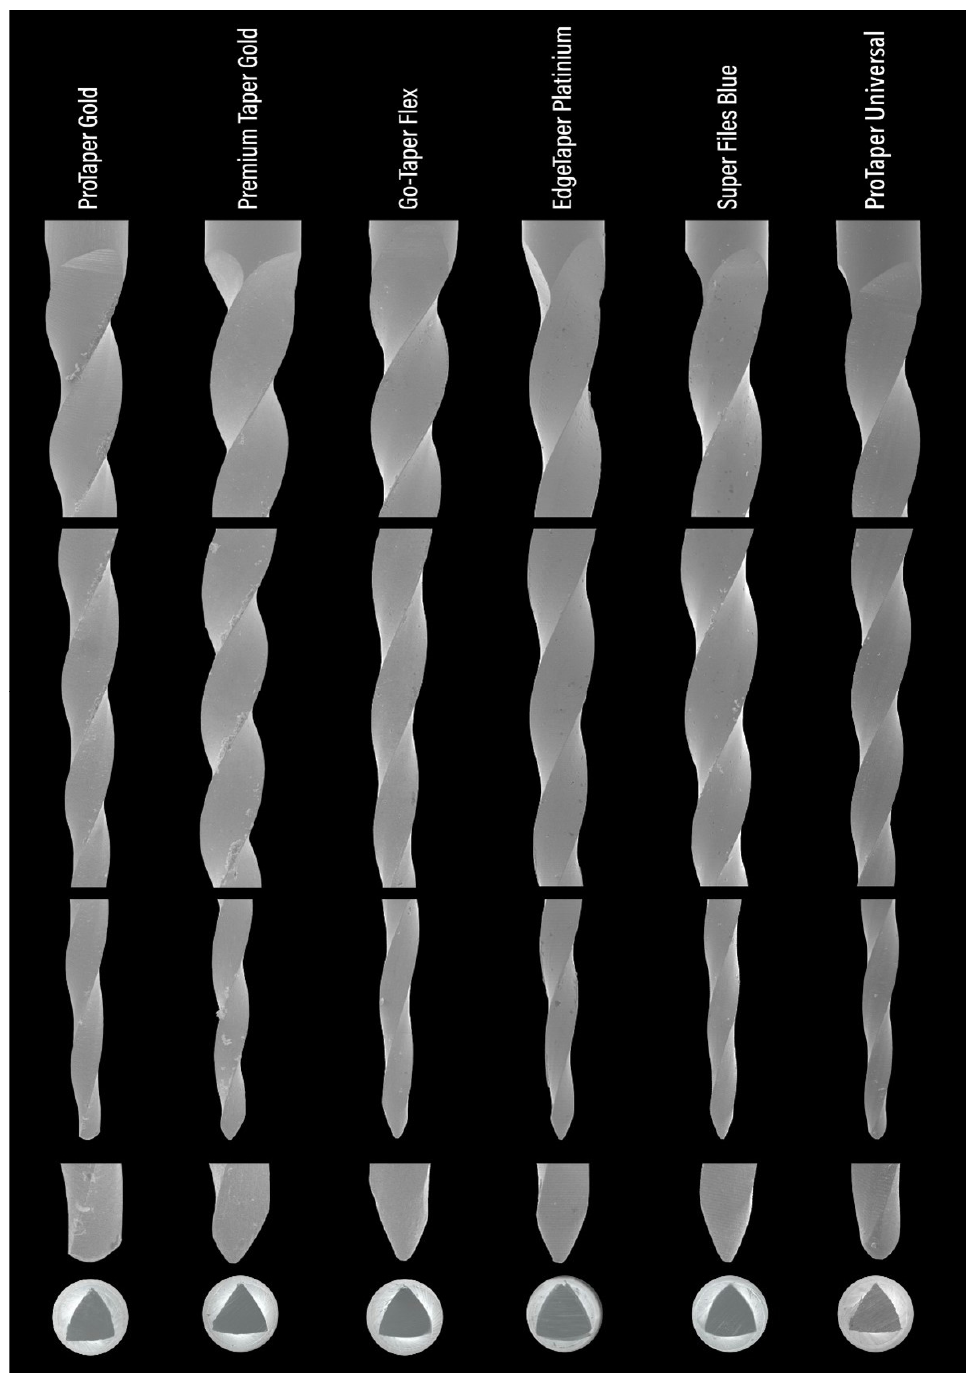
Figure 2. Representative SEM images of the tested instruments showing (from top to bottom) the coronal, middle, and apical portions of the active blades, as well as their tips’ geometry and cross- sectional design. Overall, the instruments’ designs were similar, except for the cross-sectional shape of the Premium Taper Gold instrument and the geometries of the non-active tips.